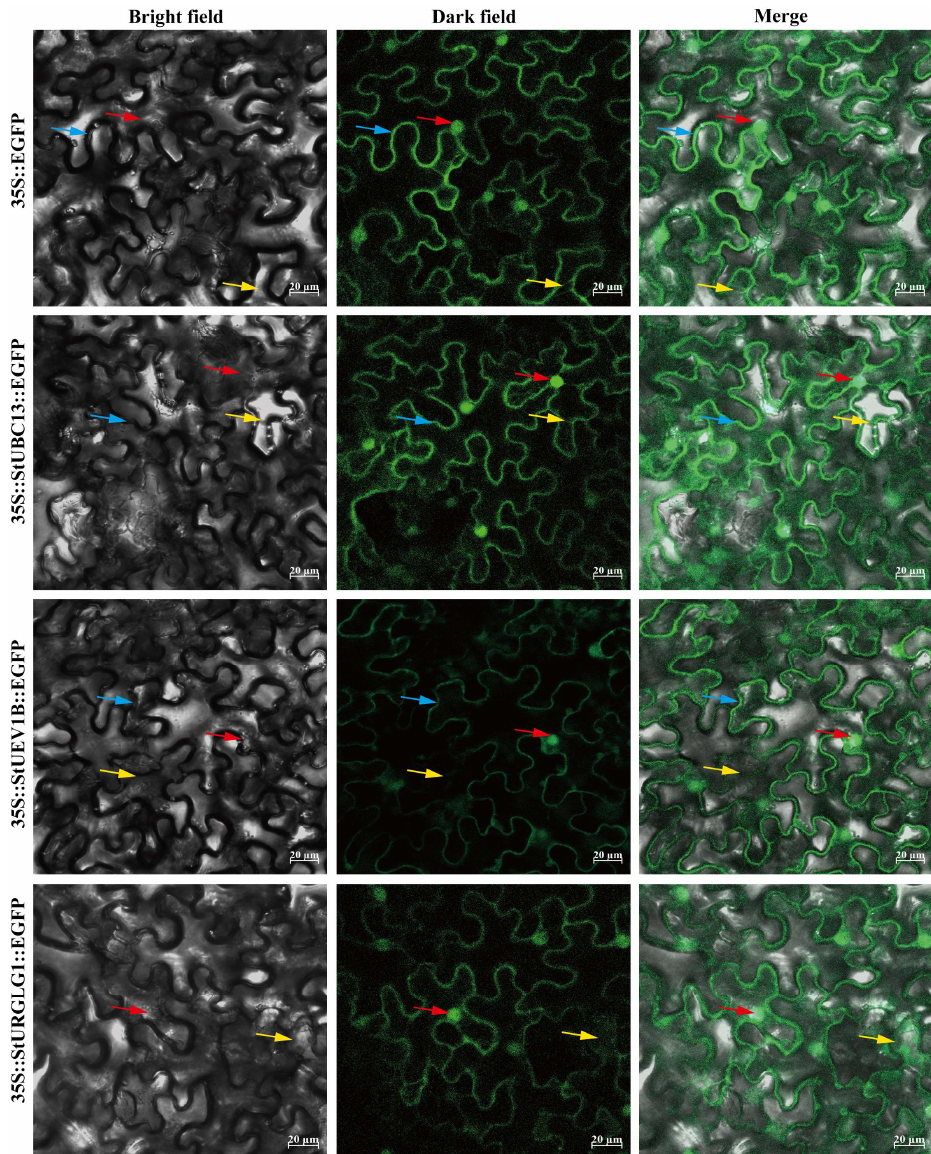
Figure 5. Subcellular localization of StUBC13 and its partners. The red arrows indicate the nucleus, the blue arrows the cell membrane, and the yellow arrows indicate membrane.